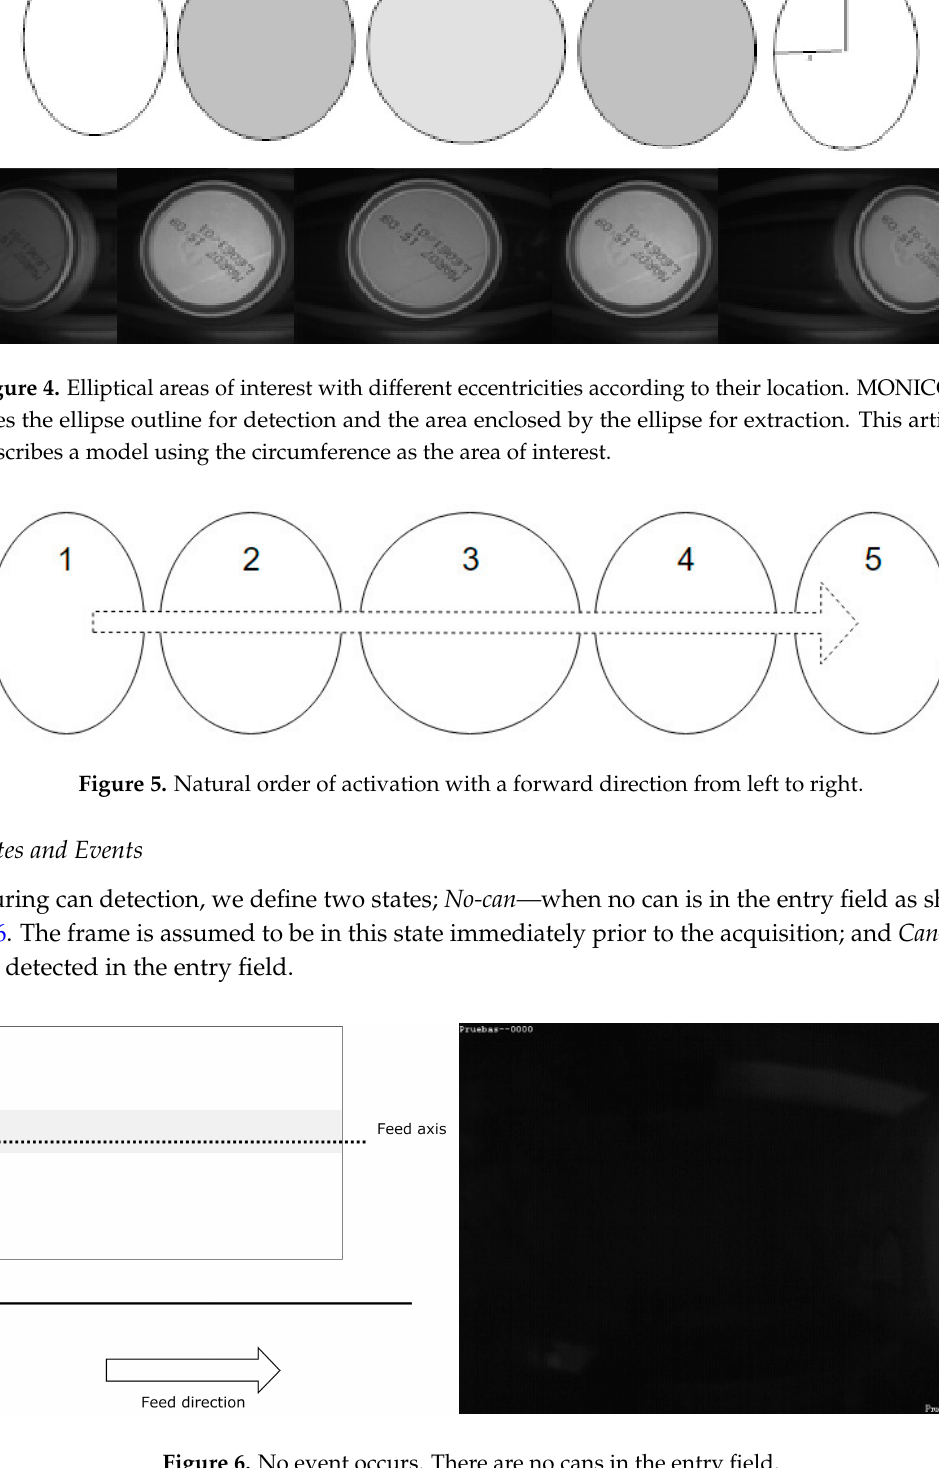
Figure 6 . No event occurs. There are no cans in the entry field. Figure 6. No event occurs. There are no cans in the entry